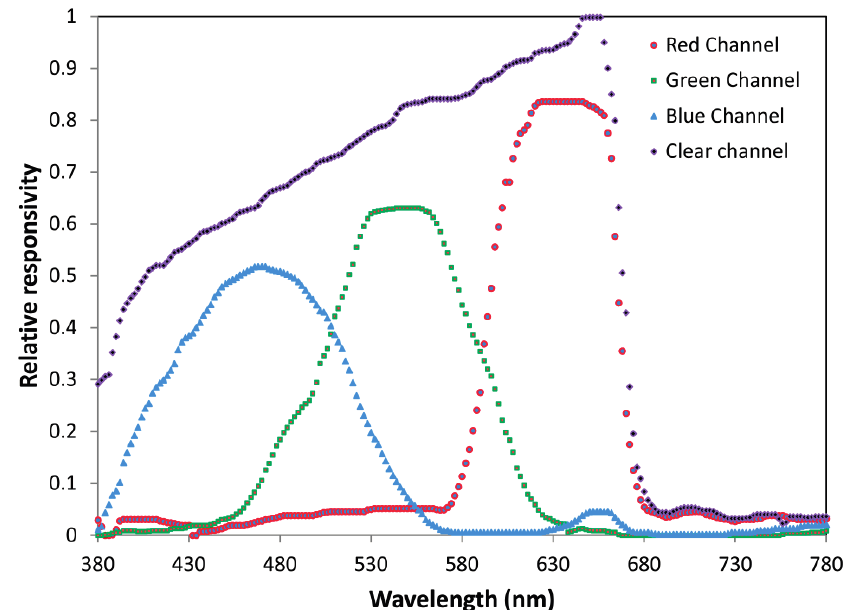
Figure 4. Spectral responsivity of the four